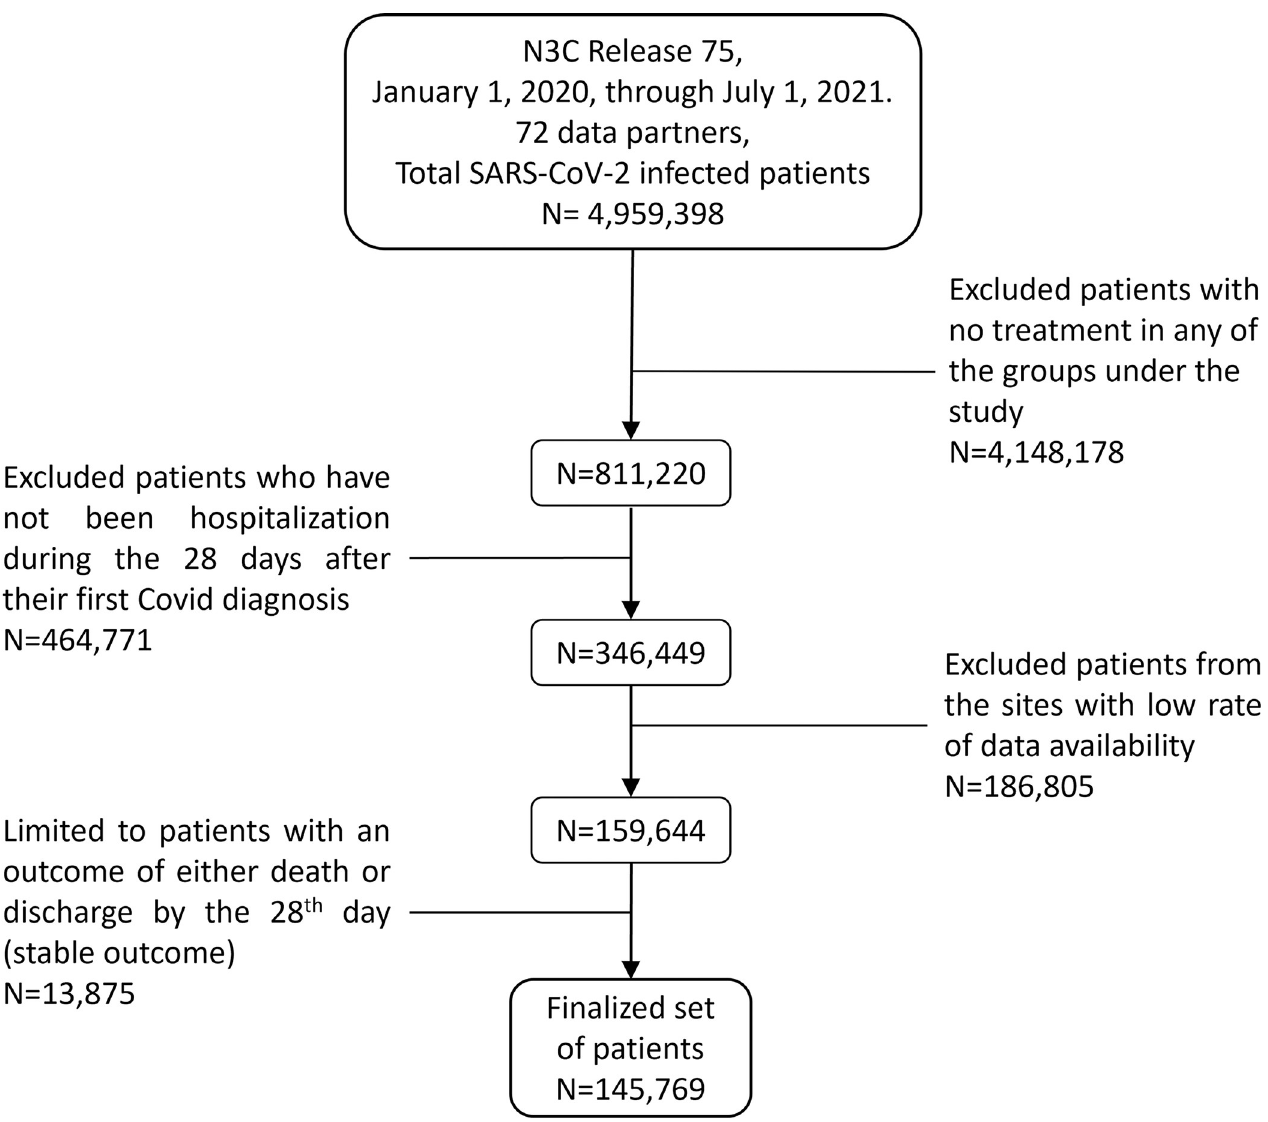
Fig 1. Information flow diagram for the cohort under the